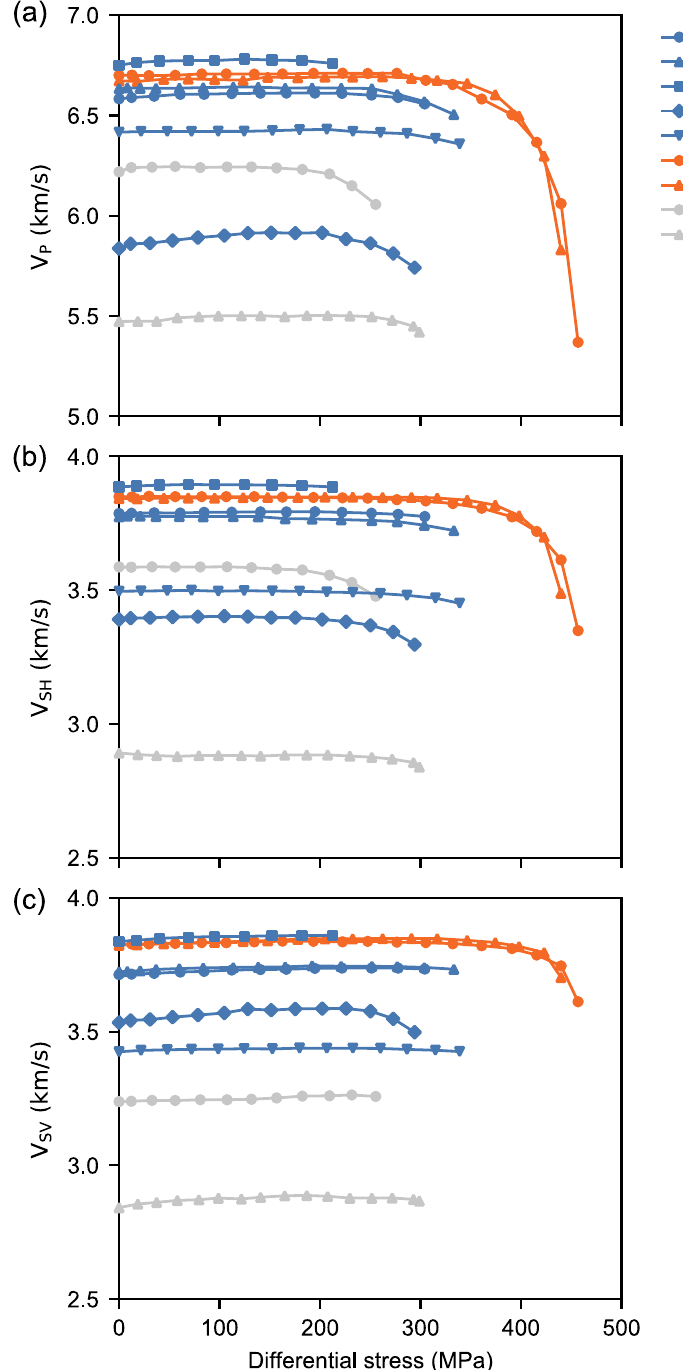
Figure 5. Elastic wave velocities recorded during deformation experiments. P- ( a ), SH- ( b ), and SV-( c ) wave velocities are plotted as a function of differential stress.